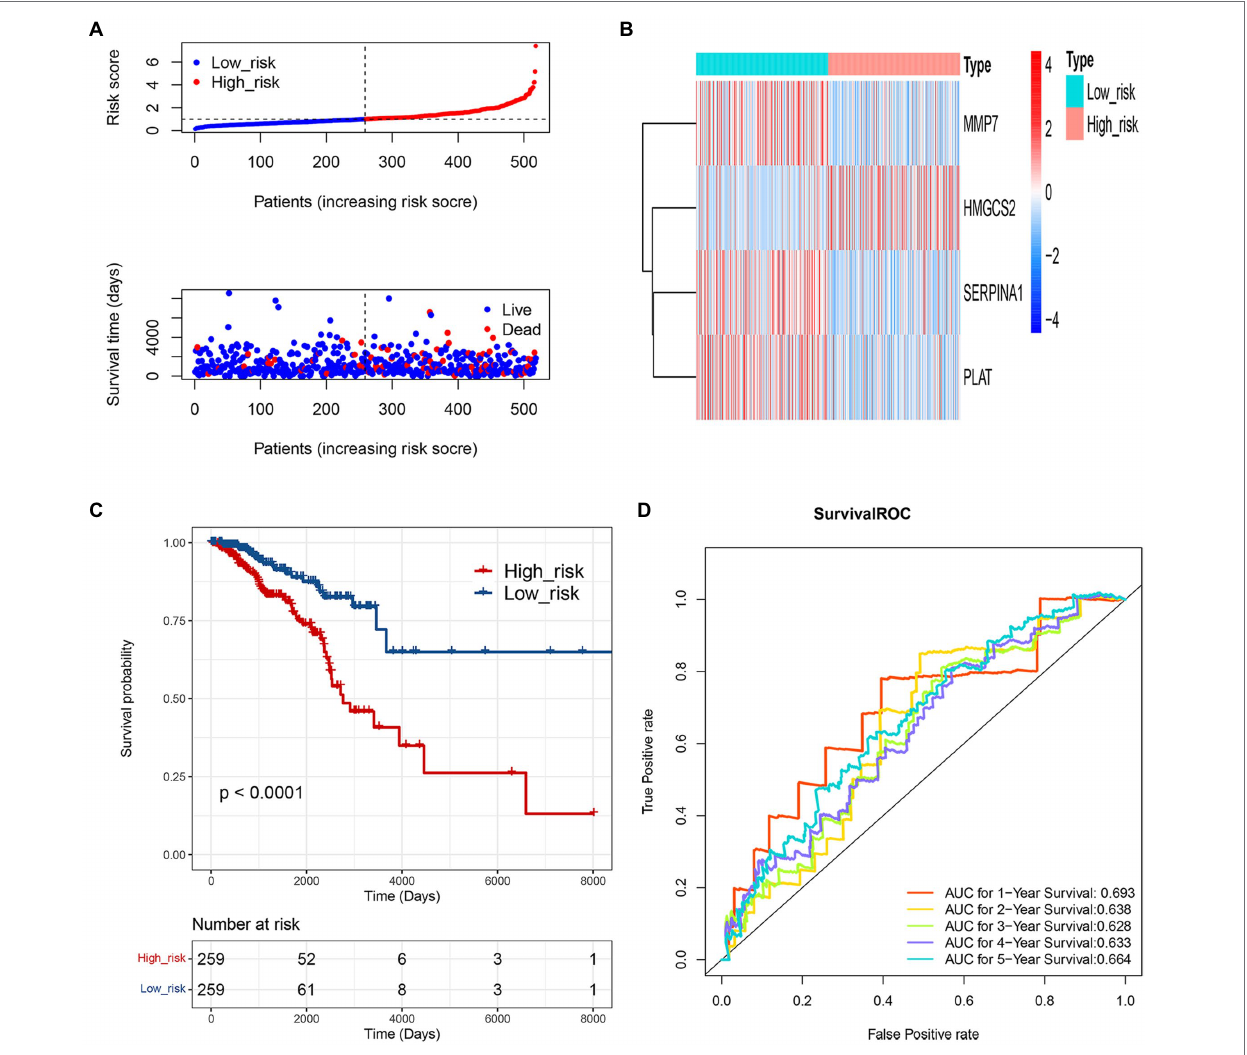
FIGURE 4 | Evaluation of the prognostic gene signature of 4 COAGULATION-related genes. (A) Risk curve and its corresponding scatter plots in the training set. (B) Heat map of risk model genes in the training set. (C) Kaplan–Meier survival curves of high- and low-risk groups in the training set. Red represents high risk, and blue represents low risk. (D) Survival ROC curves for 1-, 2-, 3-, 4-, and 5-year